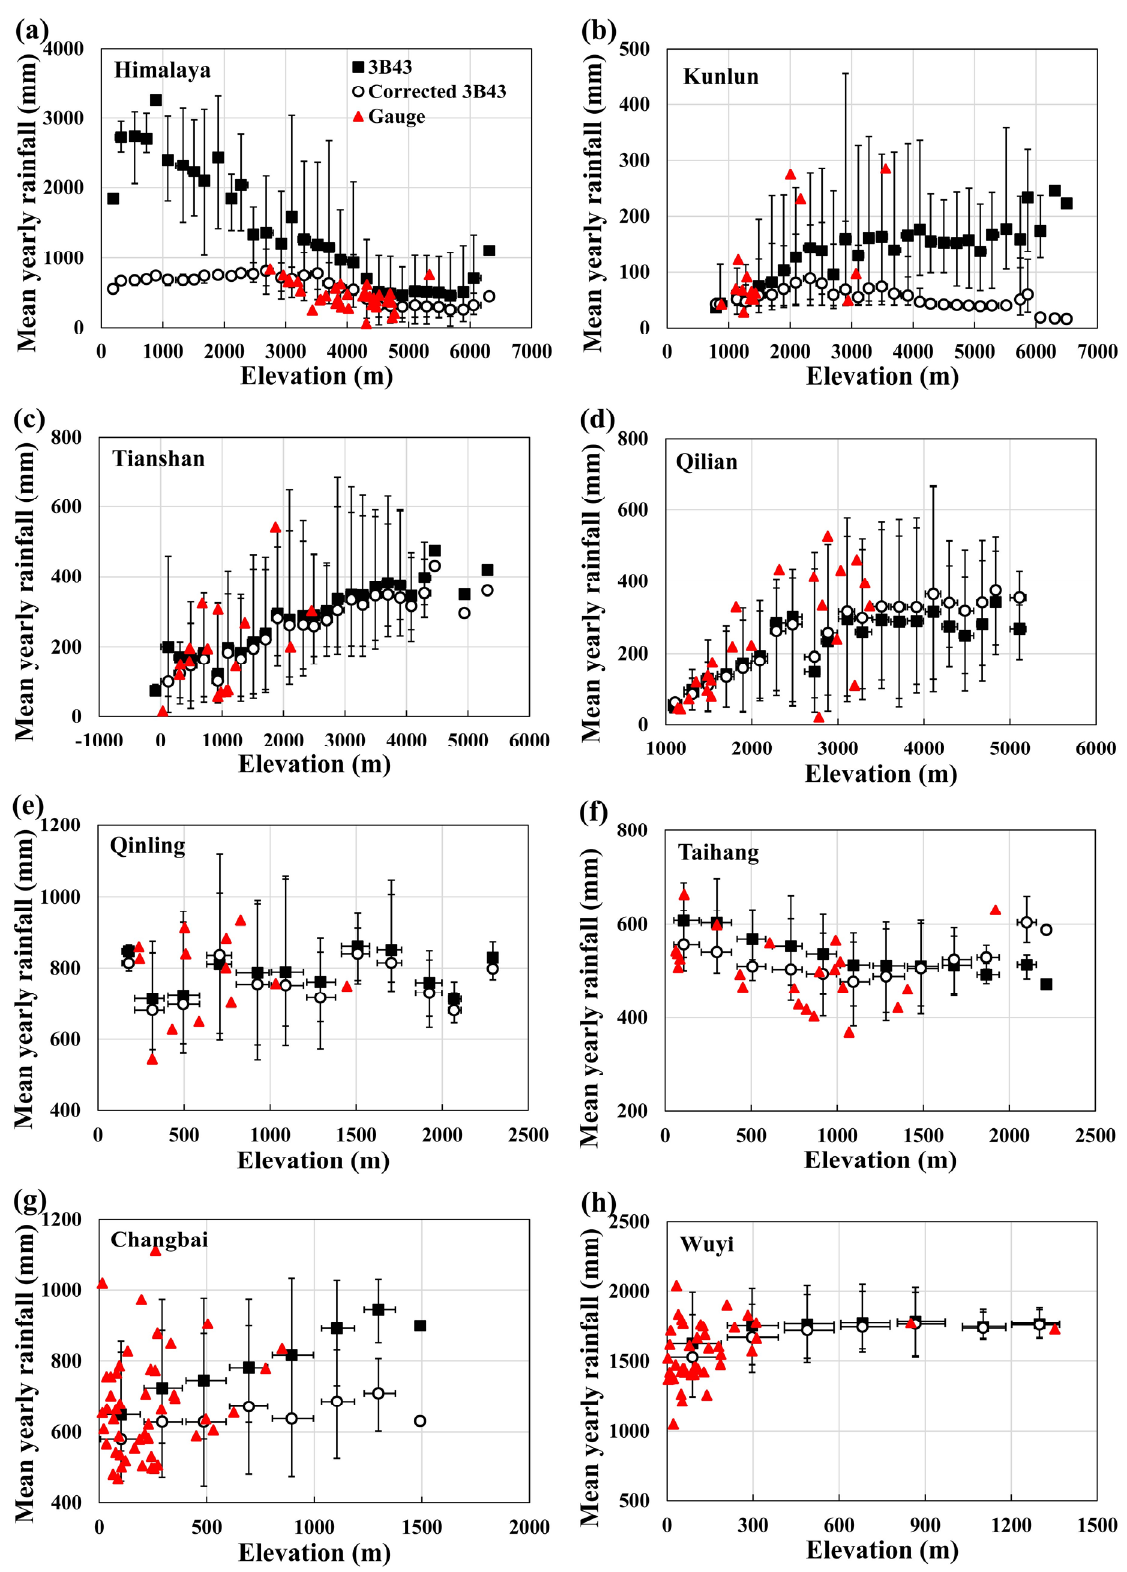
Figure 6. The original (black squares), corrected (black circles) 3B43 and gauged (red triangles) mean annual rainfalls (2001–2012) versus elevation in study areas. The error bars denote the lower 5% and upper 95% rainfall value within each elevation range. ( a ) Himalaya, ( b ) Kunlun, ( c ) Tianshan, ( d ) Qilian, ( e ) Qinling, ( f ) Taihang, ( g ) Changbai, ( h )